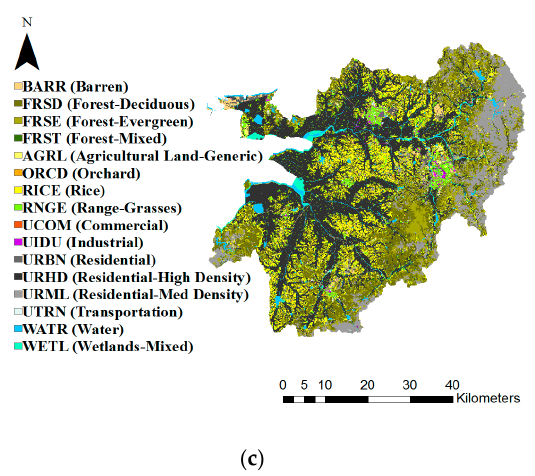
Figure 2. Input data from the study area: ( a ) digital elevation model (DEM), ( b ) soil texture map, and ( c ) land use map (Source: https://www.ngii.go.kr).